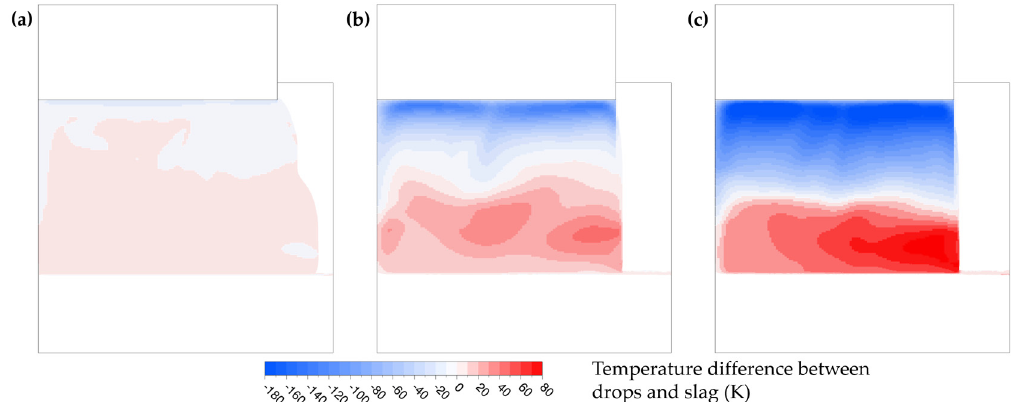
Figure 13. Temperature difference between drops and slag (time-averaged) considering the fall of 1 mm ( a ), 5 mm ( b ) and 10 mm ( c ) drops.